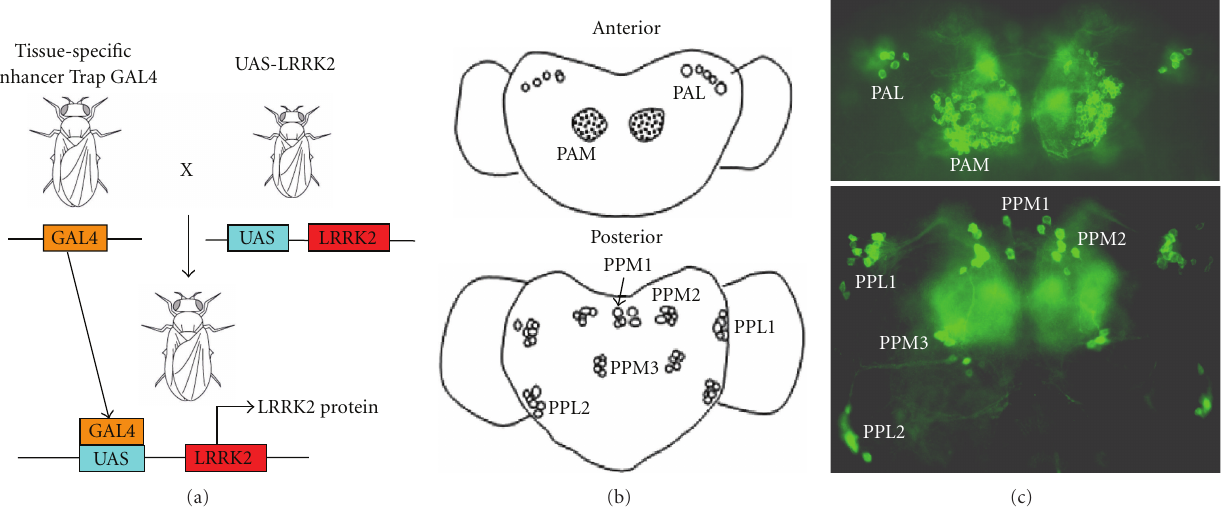
Figure 2: UAS/GAL4 system and fly brain dopaminergic neurons . A. Diagram of GAL4/UAS system to illustrate that tissue-specific expression of GAL4 leads to transcriptional activation of LRRK2. B. Diagram of DA neuron clusters in the medial and lateral areas of the adult fly brain as in previous publications [34, 67]. Five clusters: PPM1 (unpaired), PPM2 (paired), PPM3 (paired; protocerebral posterior medial), and PPL1 and PPL2 (paired; protocerebral posterolateral) on the posterior side. ( Center ) Two DA clusters: PAL (protocerebral anterolateral) and PAM (paired anterolateral medial) on the anterior side. C. Images of whole-mount-immunostaining of dopaminergic neurons in a adult fly brain using anti-TH antibodies followed by green fluorescent-conjugated second antibody